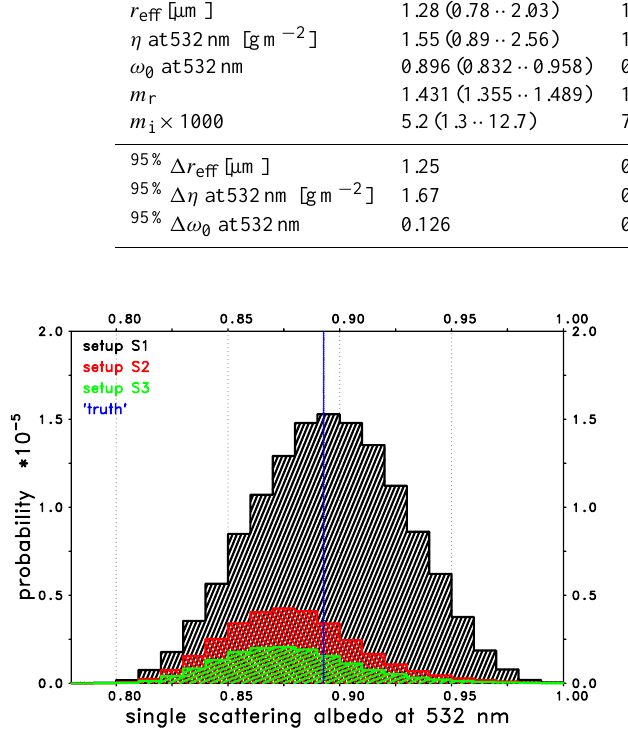
Figure 7. Probability distributions of solution ensembles for setups S1 (black), S2 (red), and S3 (green) with single scattering albedo, ω 0 , at λ = 532nm in bins of 0.01 width; ω 0 of the input ensemble (“truth”) is shown as a vertical line.